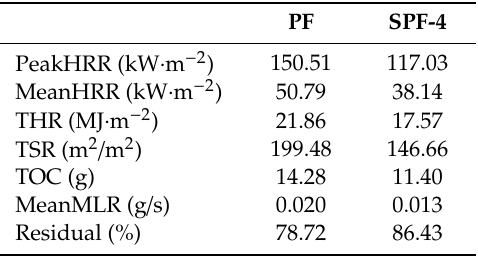
Table 3. Typical data from CC test for SPF and PF